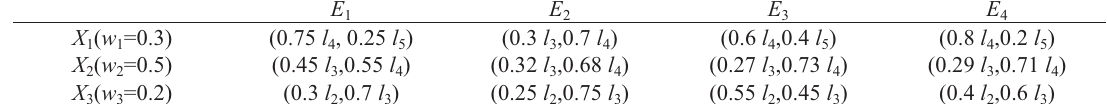
Table 3. The integrated decision matrix 1 R using PTLVs